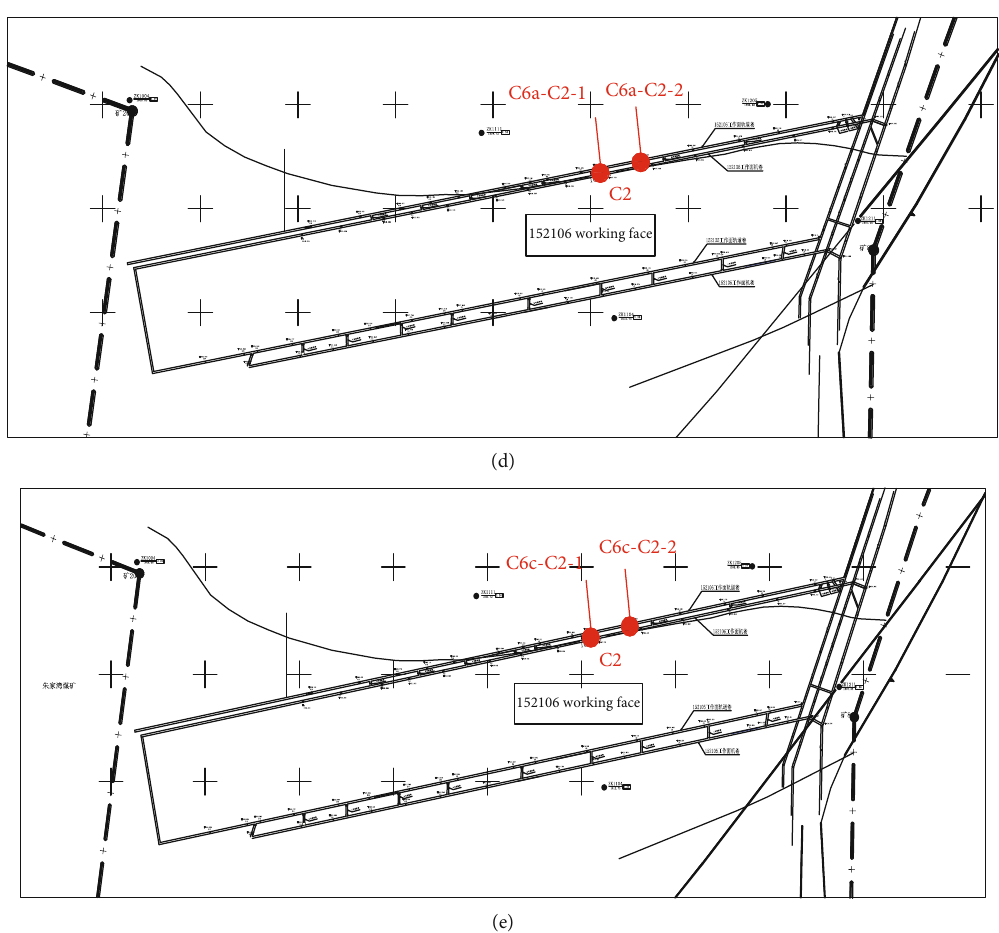
Figure 2: (a) Layout of boreholes for peeping and trajectory measurement in C 5b coal seam. (b) Layout of high-level boreholes peeping and trajectory measurement in C 5b coal seam. (c) Layout of trajectory survey boreholes in C 5a coal seam. (d) Layout of trajectory survey boreholes in C 6a coal seam. (e) Layout of trajectory survey boreholes in C 6c coal seam.